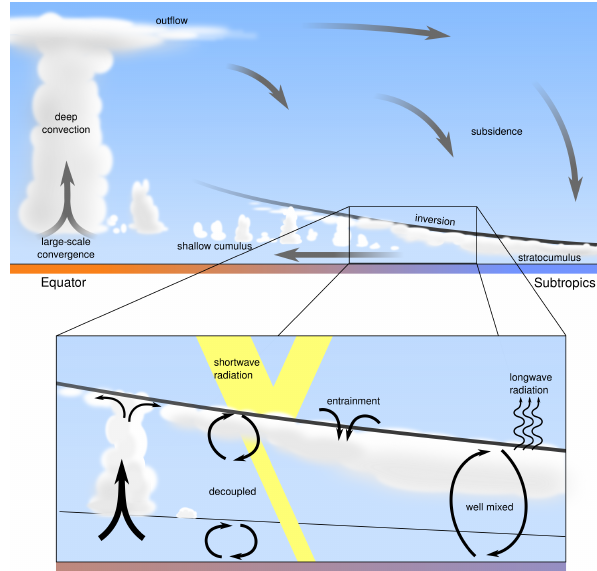
Figure 1. A schematic representation of the Hadley circulation and the cloud types that typically occur within this large-scale circu- lation (after Arakawa, 1975; Emanuel, 1994). The bottom panel zooms in on the stratocumulus transition regime within the Hadley